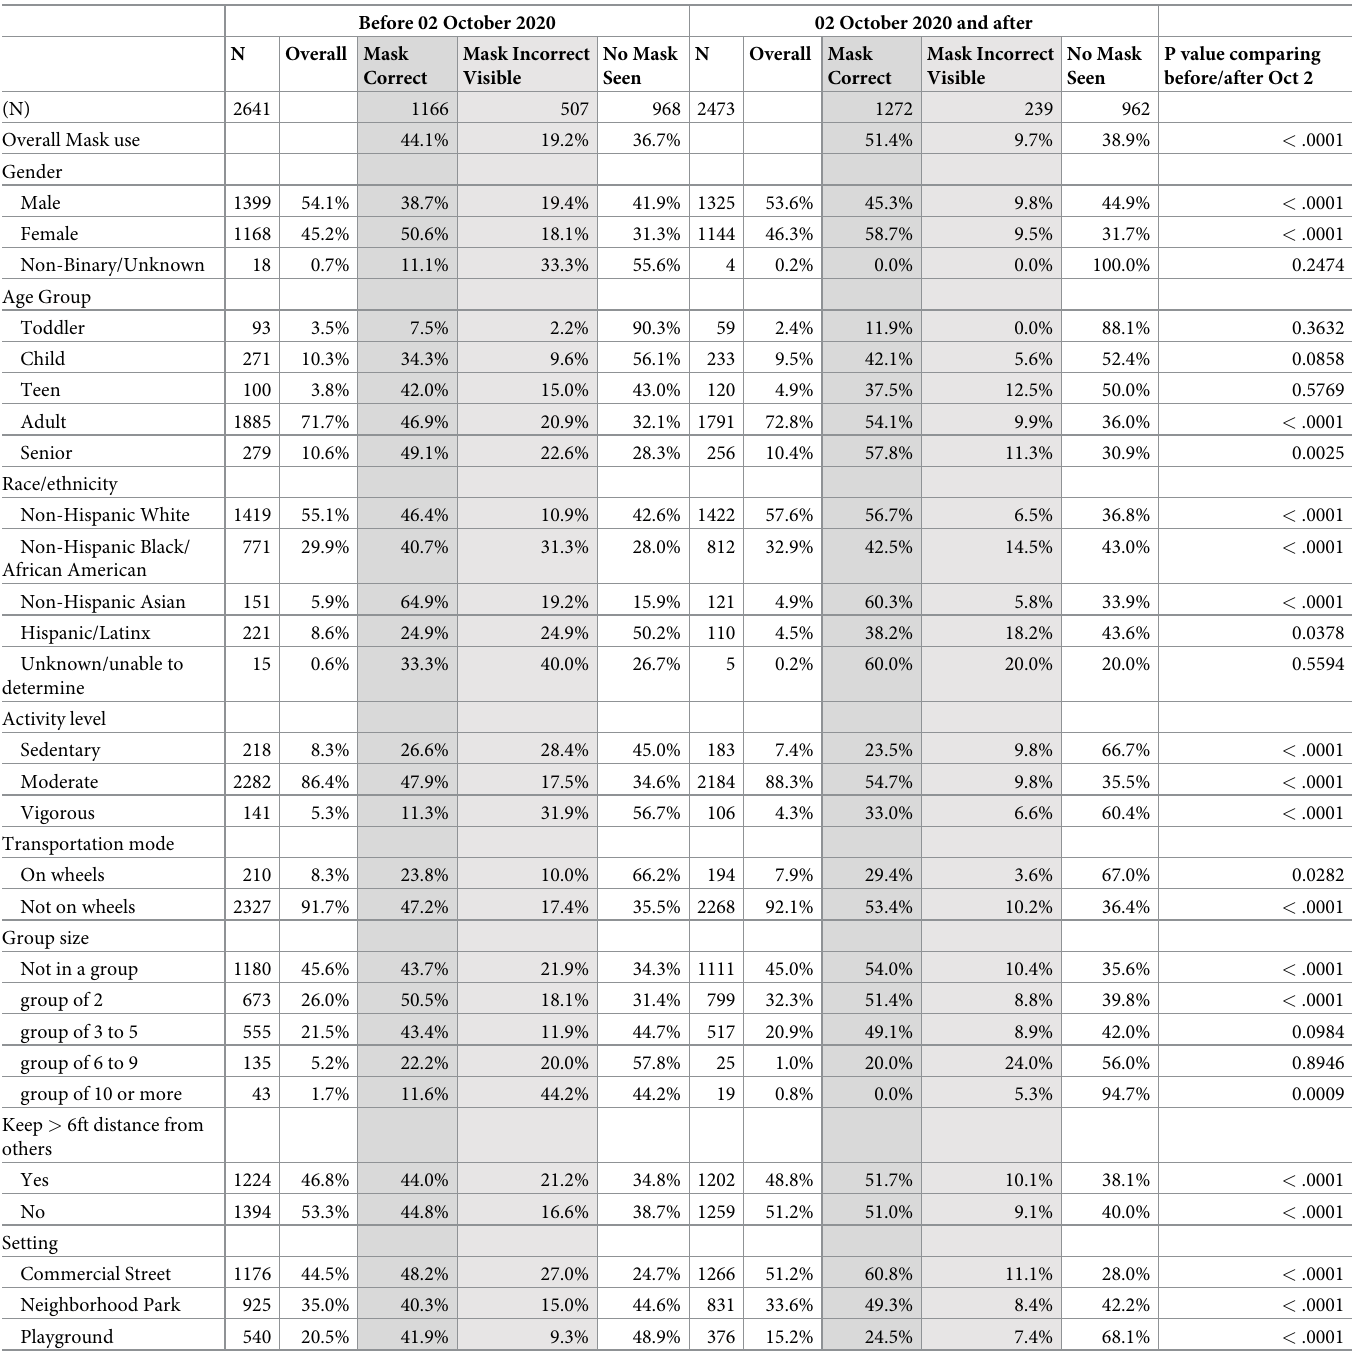
Table 1. Mask use adherence before and after Oct 2, 2020, Philadelphia